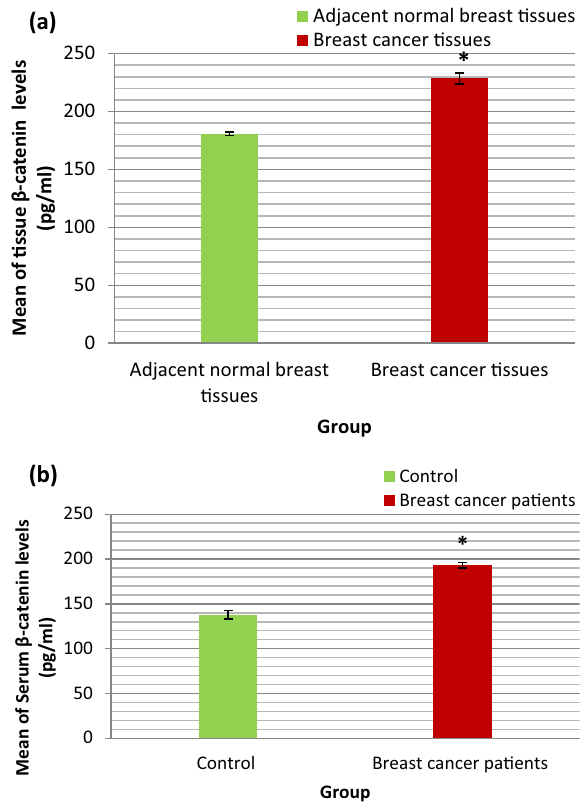
Figure 5. ( a ) Bar chart representing the mean value of β-catenin (pg/ml) in BC tissues and adjacent normal breast tissues. ( b ) Bar chart representing the mean value of serum β-catenin (pg/ml) in control group and BC patients